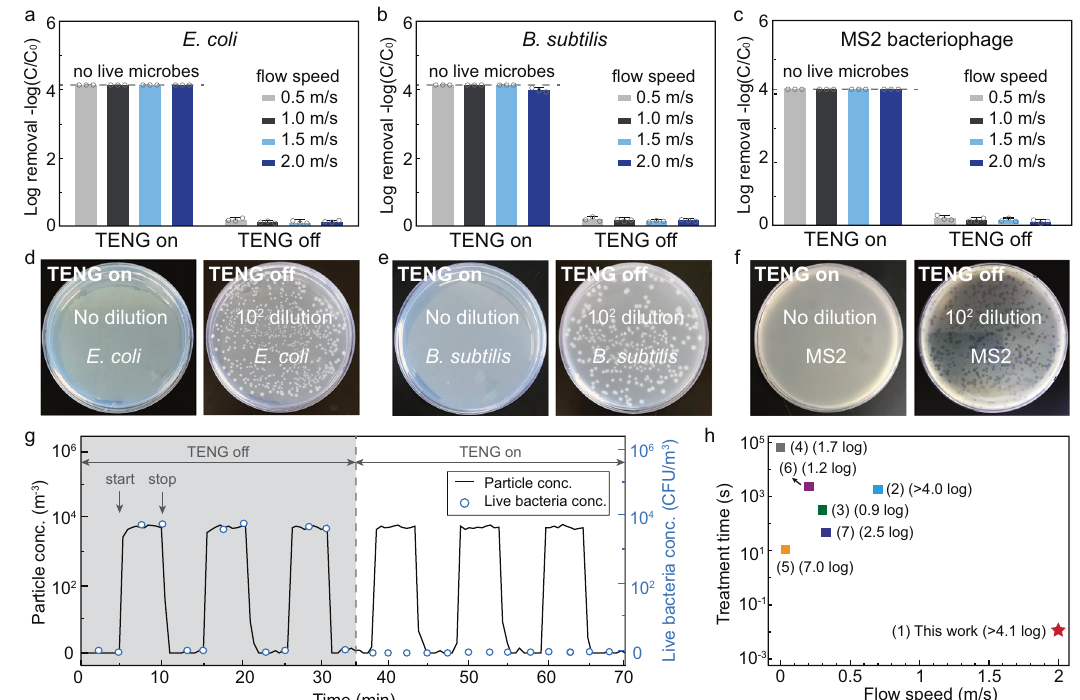
Fig. 3 Disinfection performance of the V-TENG-powered RV-disinfection method for air-transmitted microbes. a – c Disinfection ef fi ciency for Escherichia coli ( E. coli ; Gram-negative bacteria ( a )), Bacillus subtilis ( B. subtilis ; Gram-positive bacteria ( b )), and MS2 (virus; c ) using the RV-disinfection method at various air fl ow rates (from 0.5 to 2 m/s) powered by V-TENGs. d – f Plating results showing the concentration of E. coli ( d ), B. subtilis ( e ), and MS2 ( f ) after passing through RV-disinfection with or without the power from V-TENGs. g The disinfection performance of the RV-disinfection method for treating intermittent bacterial bioaerosols containing E. coli . The nebulizer with the feed solution was turned on (start) and then off (stop) for 5 min to generate an intermittent microbial bioaerosol and this periodically turning on and off leads to a periodic change of the microbial concentration. h Disinfection- performance comparison of RV-disinfection method using values in the literature describing other air disinfection methods. The plot shows speed of air fl ow with respect to treatment time for all the air disinfection methods in the comparison: (1) RV-disinfection (this work; complete disinfection, >4.1 log removal), (2) metal-organic-framework-modi fi ed fi lter (ref. 9 ; complete disinfection, >4.0 log removal), (3) TiO 2 - fi lm (ref. 12 ; 0.9 log removal), (4)